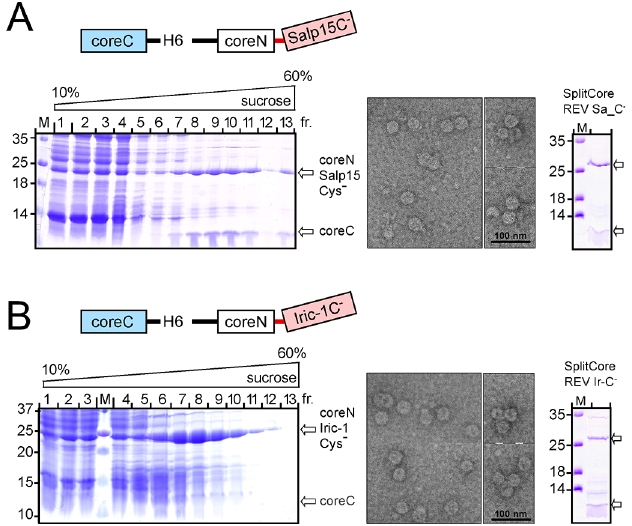
Fig 6. SplitCore REV fusions with Cys-free Salp15 and Iric-1 form regular CLPs. Cleared lysates from bacteria transformed with the indicated SplitCore REV constructs were subjected to sucrose gradient sedimentation and analyzed by SDS-PAGE as in Fig 3B. The positions of the large and small SplitCore fragments is indicated by arrows. (A) CoreN fusion with Cys-free Salp15. Left : Coomassie Blue stained SDS-PAGE gel. Middle : Negative staining EM of material from fraction 8. Sometimes aggregates of several particles were observed (smaller fields on the right). Right : SDS-PAGE analysis of the final preparation